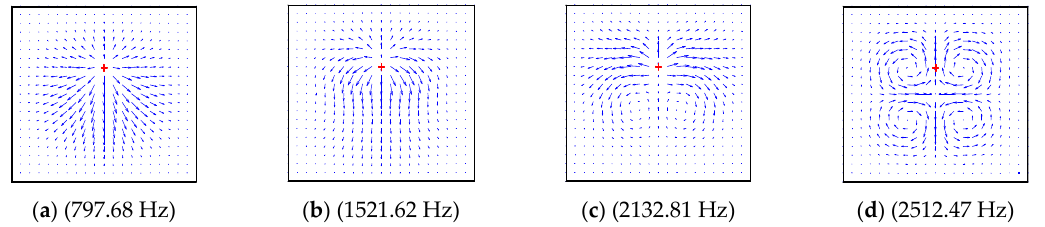
Figure 15. The power flow field for a CCCC laminated plate excited by point force on (0.5 m, 0.65 m). ( a ) (797.68Hz), ( b ) (1521.62 Hz), ( c ) (2132.81 Hz), ( d ) (2512.47 Hz).